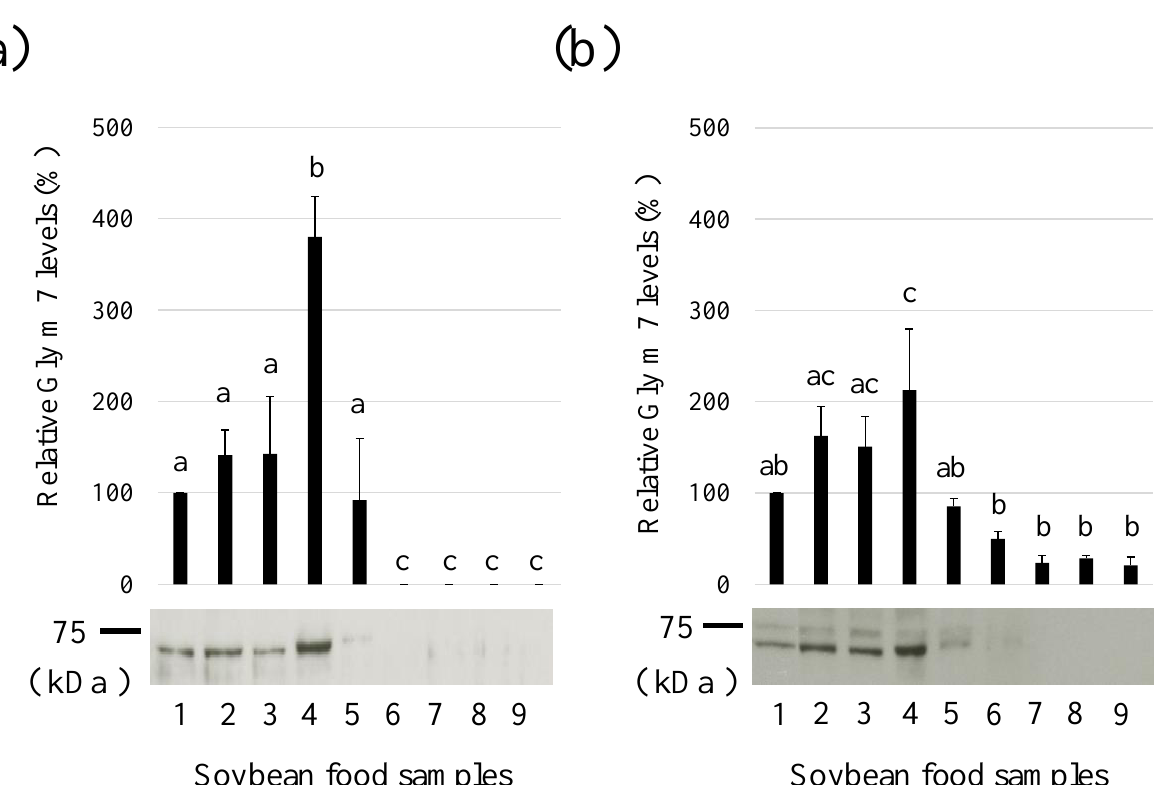
Figure 3. Relative levels of Gly m 7 allergens in processed soybean food samples. ( a ) Gly m 7 levels were detected by anti-Gly m 7 antibodies ( b ) Relative levels of Gly m 7 in various processed soybean food samples using horseradish peroxidase-labeled streptavidins. Processed soybean food samples (10 µg ( a ) or 100 µg ( b ) protein/lane) were separated via sodium dodecyl sulphate–polyacrylamide gel electrophoresis, and the Gly m 7 levels were detected. There are significant differences ( p < 0.05) between different lowercase letters. (lane 1, standard soymilk; lane 2, kinugoshi-tofu; lane 3, momen-tofu; lane 4, thick fried tofu; lane 5, thin fried tofu; lane 6, boiled soybeans; lane 7, kome-miso; lane 8, shiro-miso; lane 9, natto).